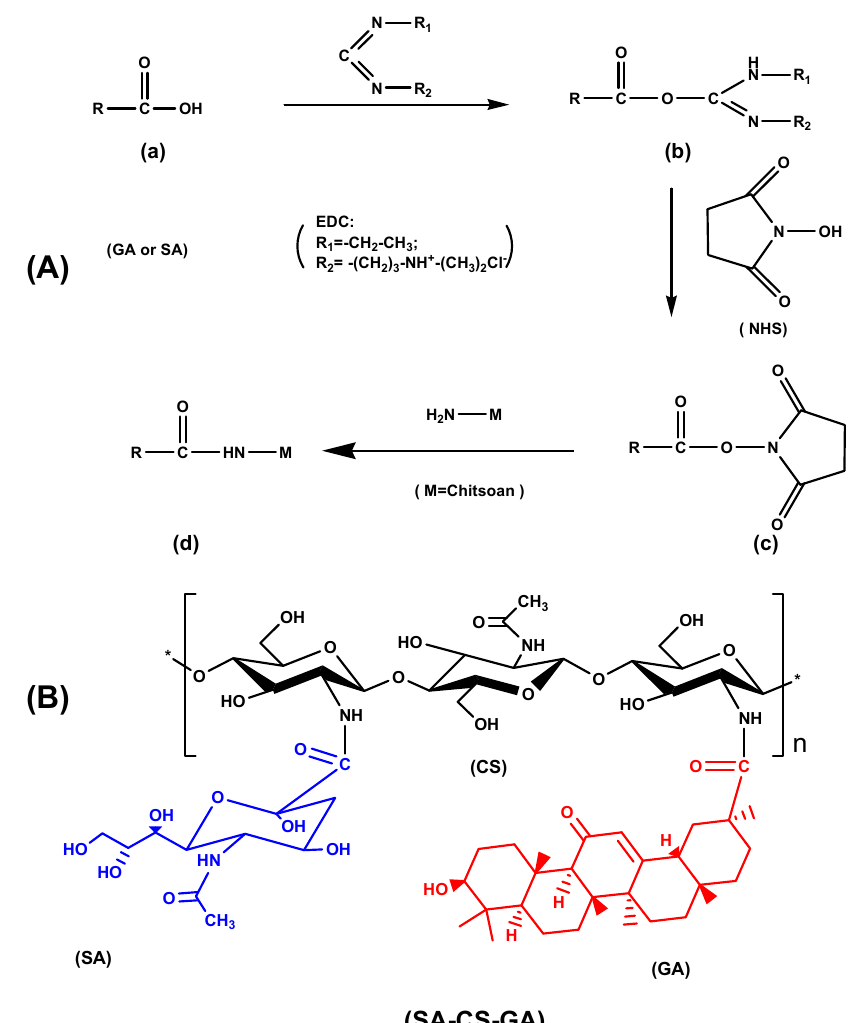
Figure 1. Graft mechanism of chitosan (CS) and 18 β -glycyrrhetinic acid (GA) or sialic acid (SA) in the presence of N -(3-Dimethylaminopropyl)- N ’-ethylcarbodiimide hydrochloride/ N -hydroxy- succinimide (EDC/NHS) ( A ); molecular structure of amphiphilic chitosan ( B ).